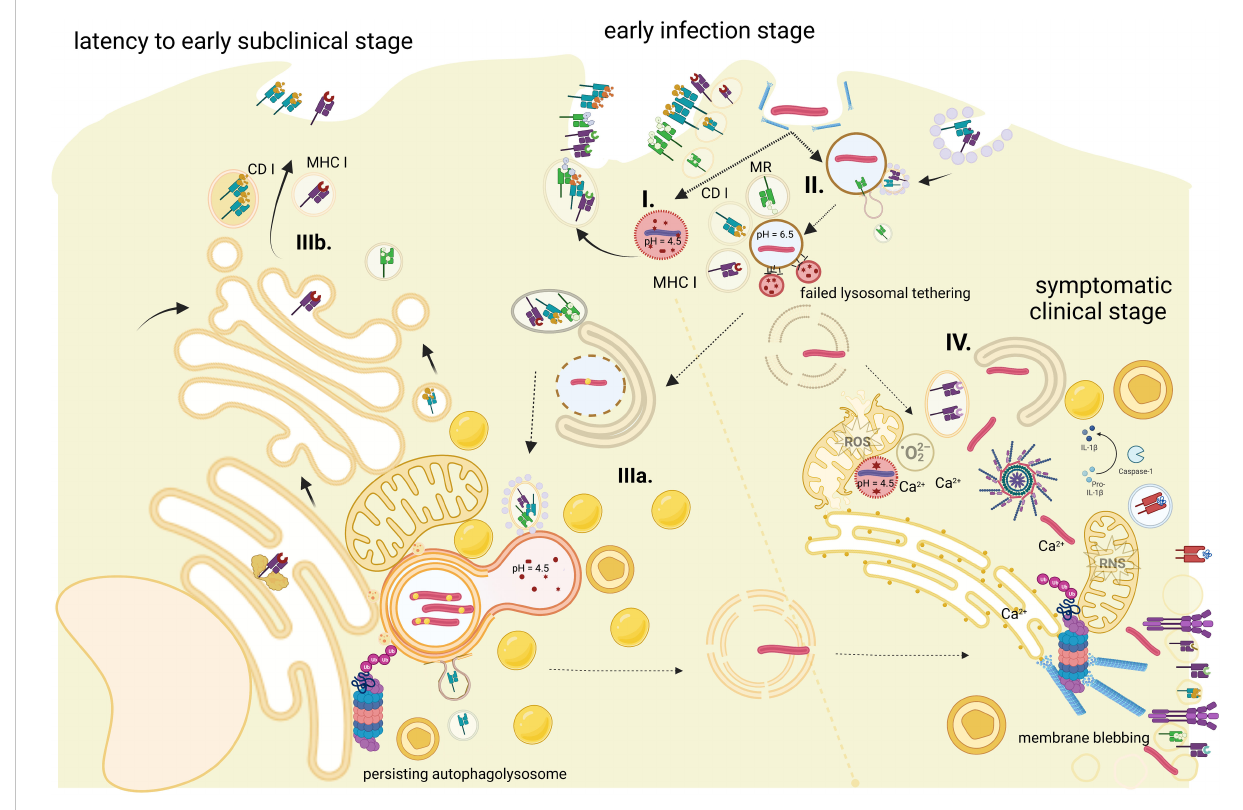
FIGURE 1 Antigen processing for MHC-I presentation during the course of Mtb infection. The fi gure represents stages of phagocytosed bacilli (pathways are time- and site-speci fi c). (I) The phagolysosome, which disables pathogen — presented antigens are from fragmented dead bacilli. (II) Persistent phagosomes where fusion with lysosome was blocked successfully by the bacilli — presented antigens are virulent factors released by live Mtb . (III) Autophagolysosomes with persistent latent bacilli — presented antigens are scanty and a by-product of pathogen – host cellular organelles interactions: (IIIa) stage of autophagosome nucleation initiation and (IIIb) a stage of persisting autophagolysosome via contact sites with ER and classical MHC-I antigen processing route. (IV) Cytosol bacilli — stage of active infection with Mtb overtaking cell innate defense, generalized disruption of cell functions, and likely progress to cell death. Dashed arrows represent pathogen transition; solid arrows represent sources of the antigen. Created with